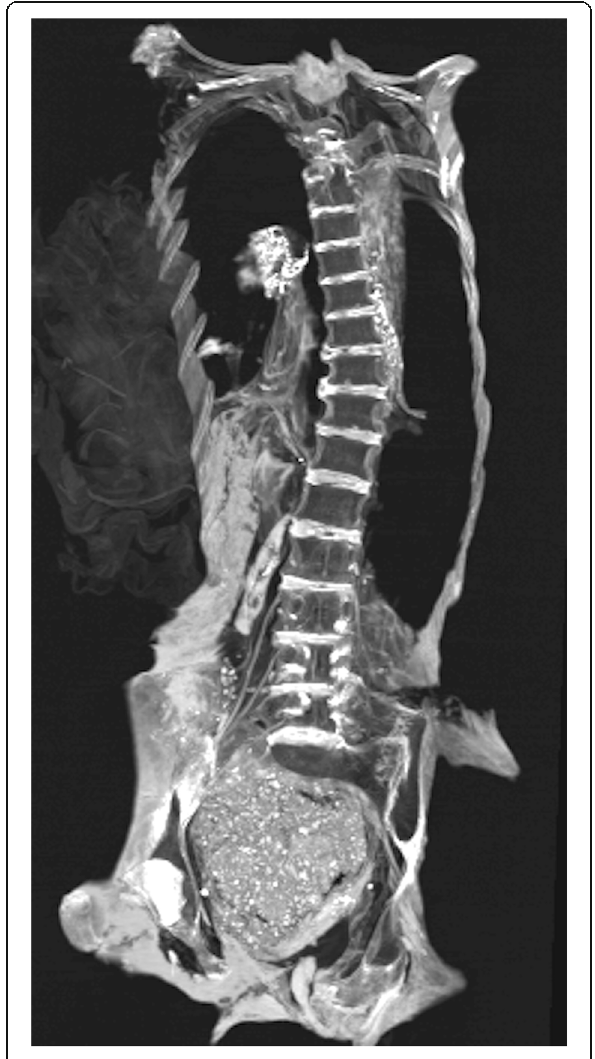
Fig. 5 Coronal CT image of the torso of “ Unknown-Woman-A ” shows the mummification style. Evidence of evisceration and embalming material placed within the abdomino-pelvic cavity. Note the mild positional scoliosis of the spine